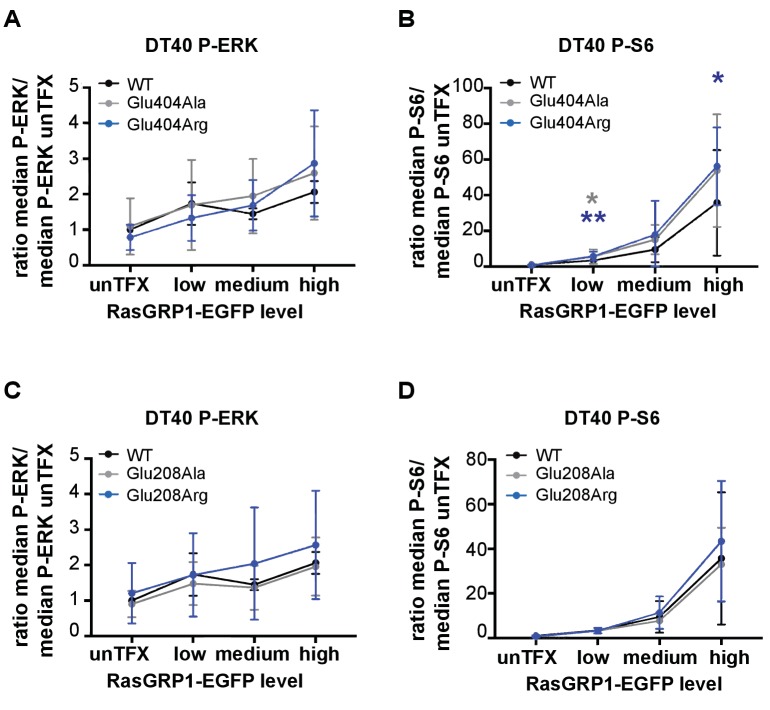
Basal signaling activity of RasGRP1 WT and Glu 404 (A,B), or Glu208 (C,D) variants in RasGRP1−/−RasGRP3−/− DT40 cells.Shown are average median levels of P-ERK (A, C) and P-S6 (B, D), corrected for untransfected cells for each experiment. Friedman test was used, with post-test Dunn's multiple comparisons, comparing each mutant to WT. (RasGRP1 low N = 6, RasGRP1 medium (N = 5 for P-ERK, N = 6 for P-S6), RasGRP1 high (N = 4). All graphs show mean ±SD. *p<0.05 and **p<0.01.